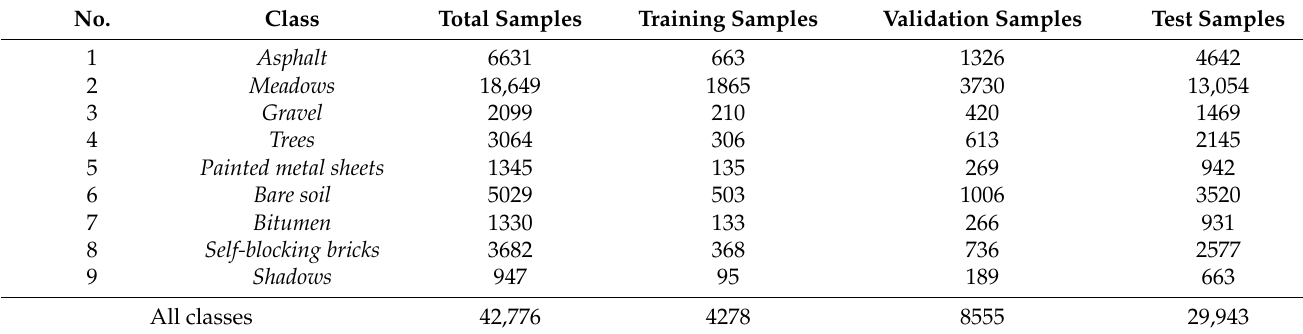
Table 1. The division of samples for each class in the hyperspectral